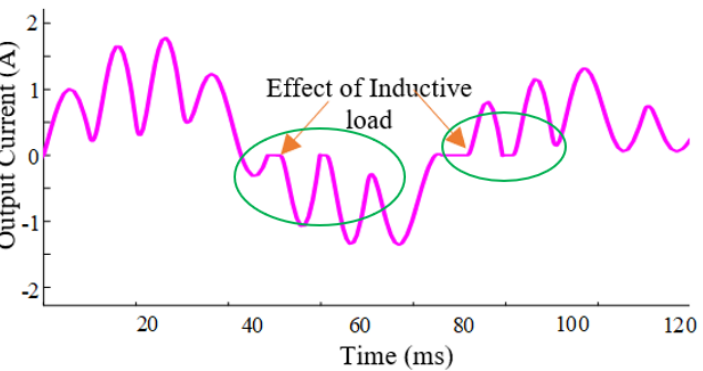
Figure 13. Output current of one − fourth frequency conversion of input frequency for motor load.